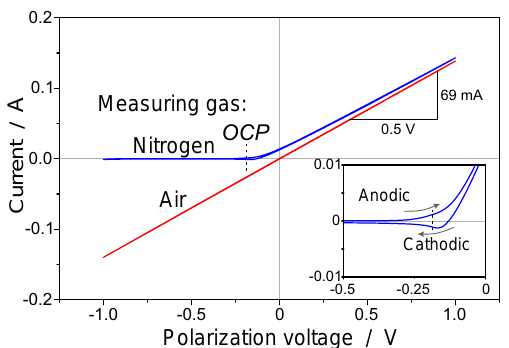
Figure 1. Experimental setup of the solid electrolyte sensor (elec- trode areas A: cell 1: A(m1) = 7.5cm 2 and A(ref1) = 11.3cm 2 ; cell 2: A(m2) = 0.75cm 2 and A(ref2) = 1.13cm 2 ) with a cyclic voltam- metric measuring unit; U p ( t ): linearly and cyclically varying polar- ization voltage; I ( t ): measured current.